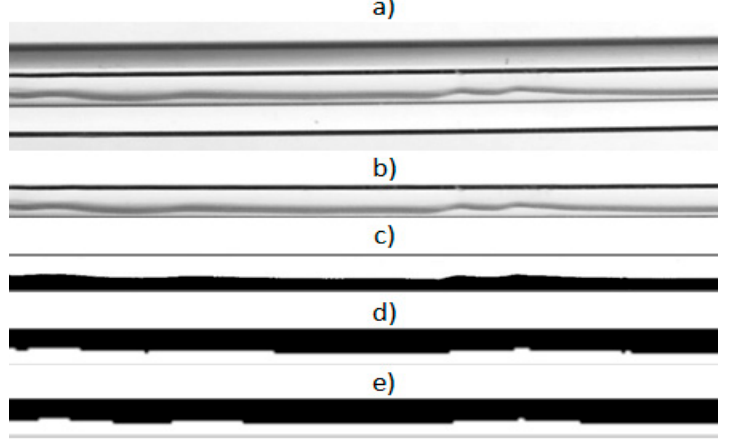
Figure 4. Graphical interpretation of the image processing steps before the analysis: ( a ) film frame; ( b ) image after cutting the interior of the minichannel; ( c ) binary image; ( d ) image after inverting the colors by the algorithm; ( e ) image after removing the noise by the algorithm [36,37].